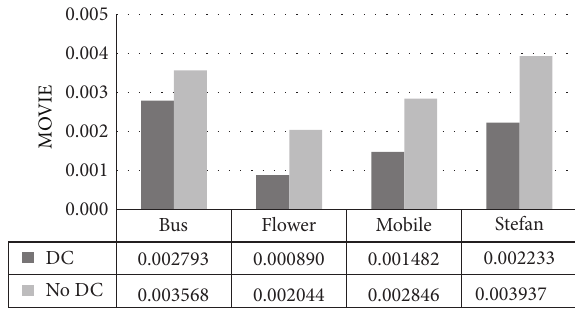
Figure 17: MOVIE comparison between schemes with DC and without DC.